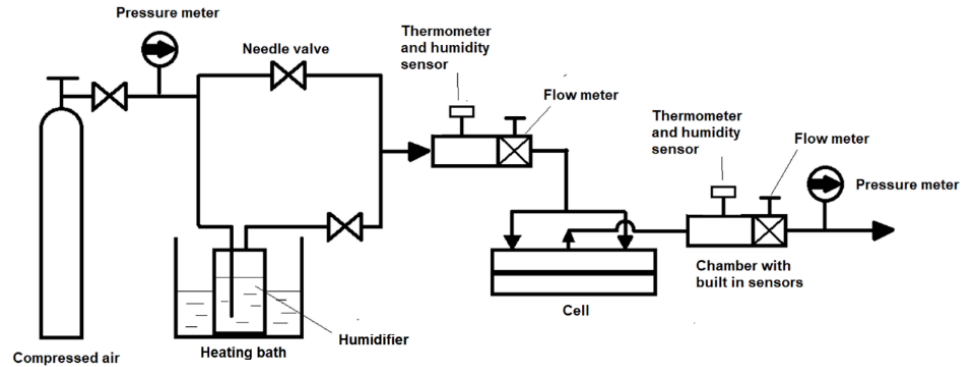
Figure 1. Scheme of the test rig.